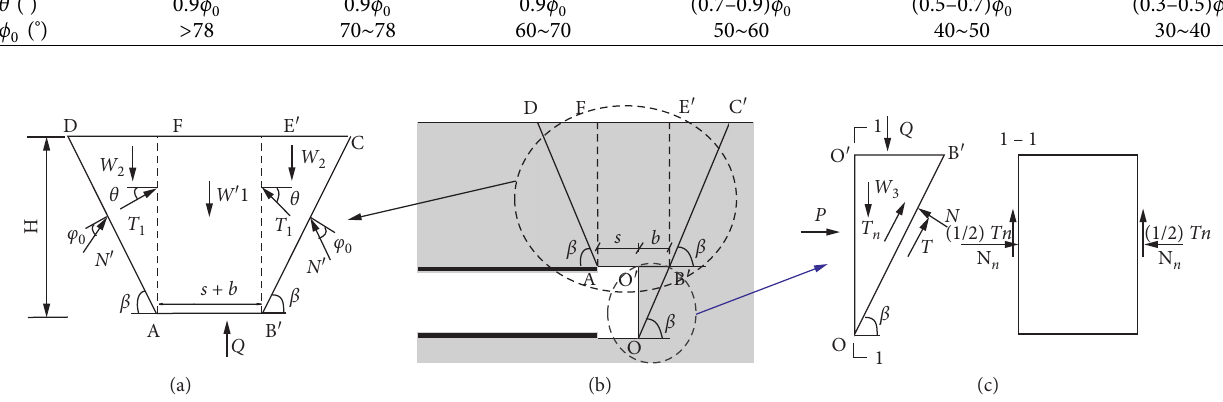
Figure 6: Calculation diagram for stability analysis of the face. (a) Calculation diagram. (b) Failure mode. (c) Calculation